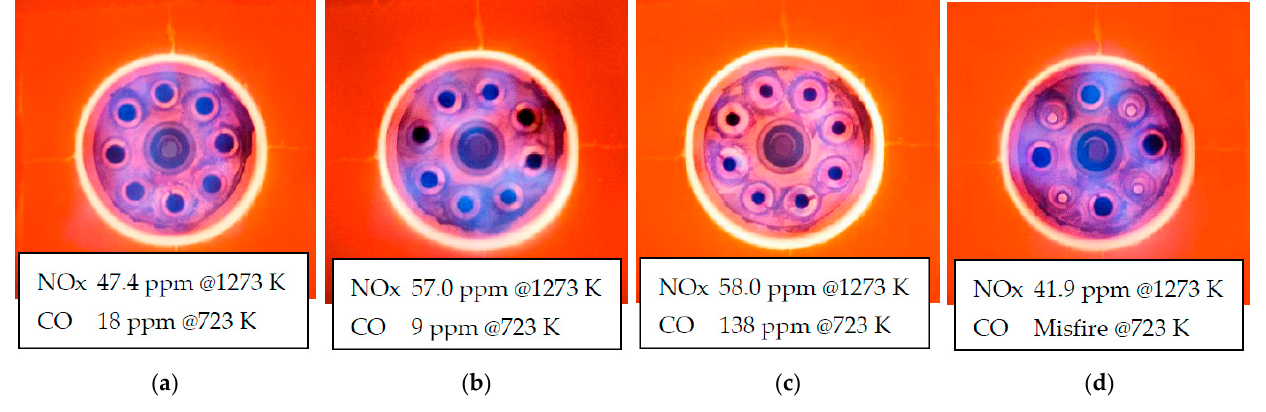
Figure 6. Flame photographs at E H2 = 0% and 1273 K of ( a ) φ 11.9 × 8; ( b ) φ 10.2 × 8; ( c ) φ 8.4 × 8; ( d ) φ 11.9 × 4. Input = 174 kW, λ = 1.2, P = +15 Pa.